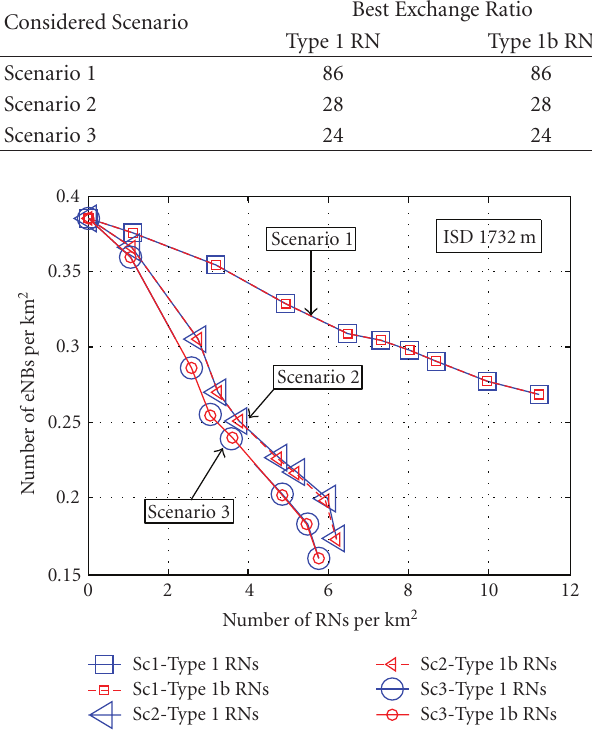
Figure 4: ISO-performance curve - ISD 1732 m.